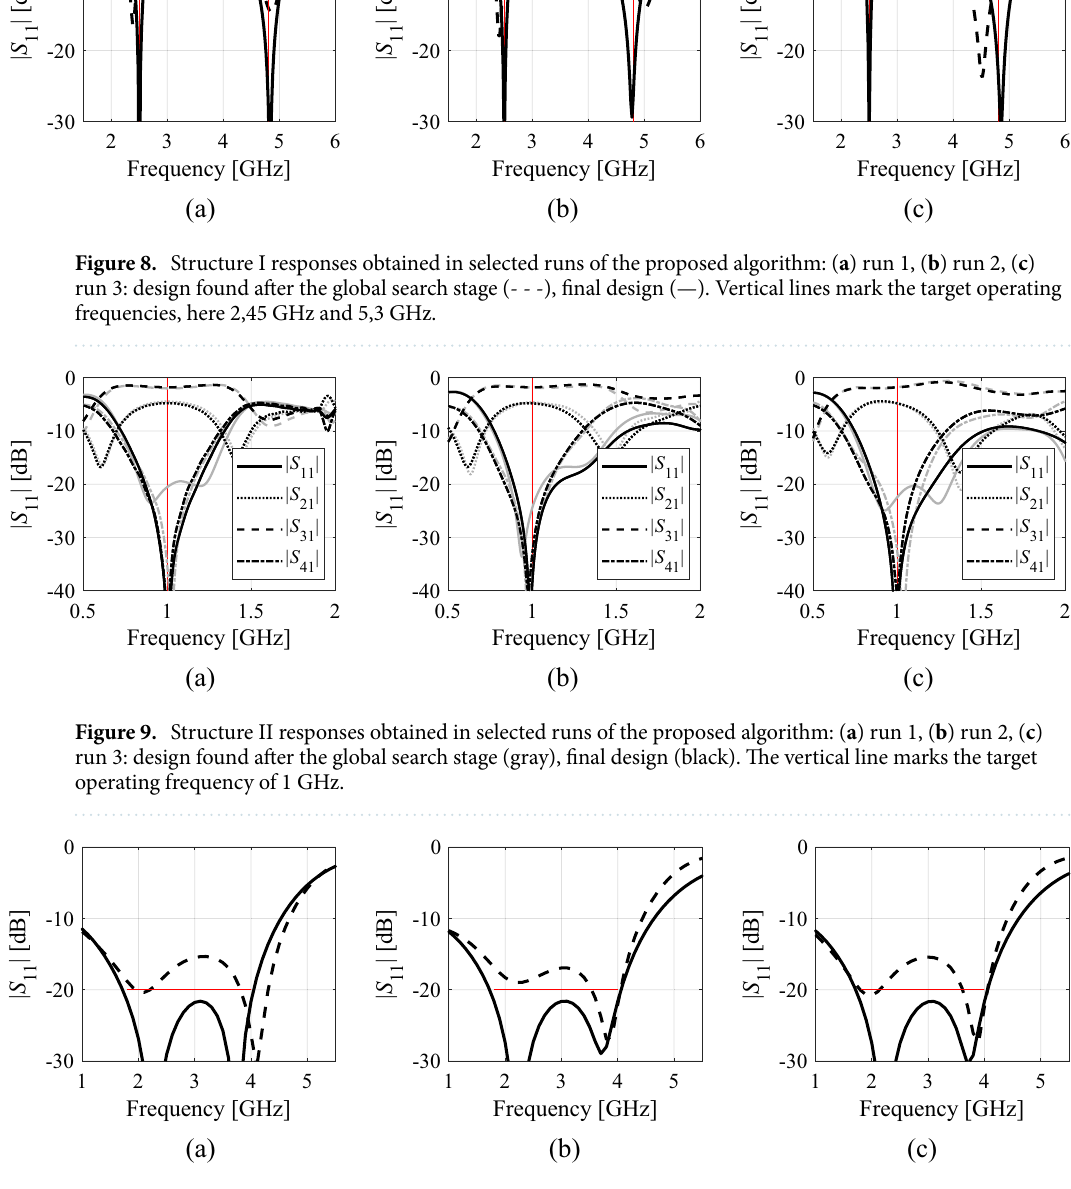
Figure 10. Structure III responses obtained in selected runs of the proposed algorithm: ( a ) run 1, ( b ) run 2, ( c ) run 3: design found after the global search stage (- - -), final design (—). The horizontal line marks the intended operating bandwidth, here, from 1.8 GHz and 4.0